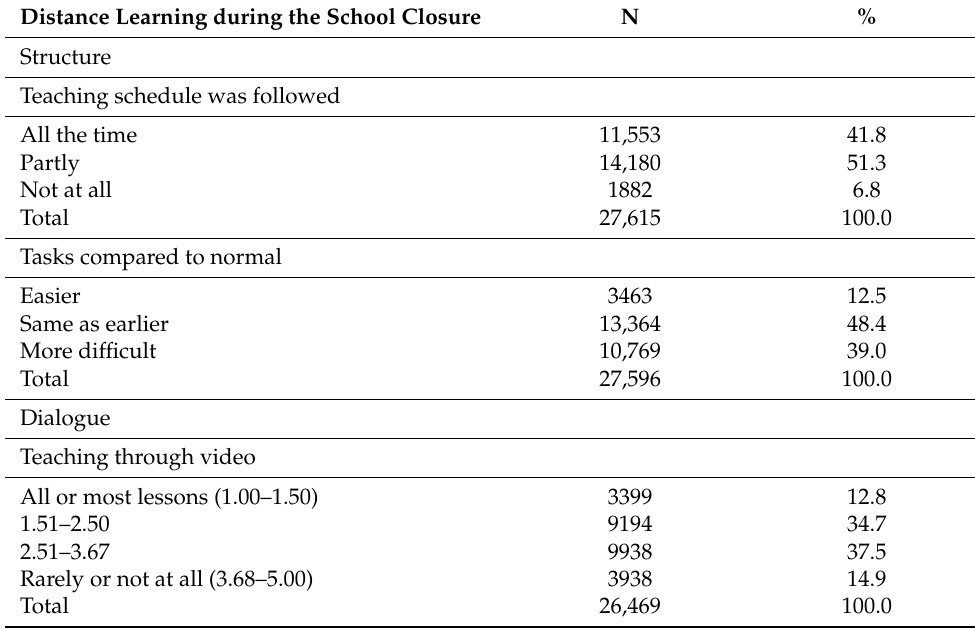
Table 2. Distributions of the explanatory